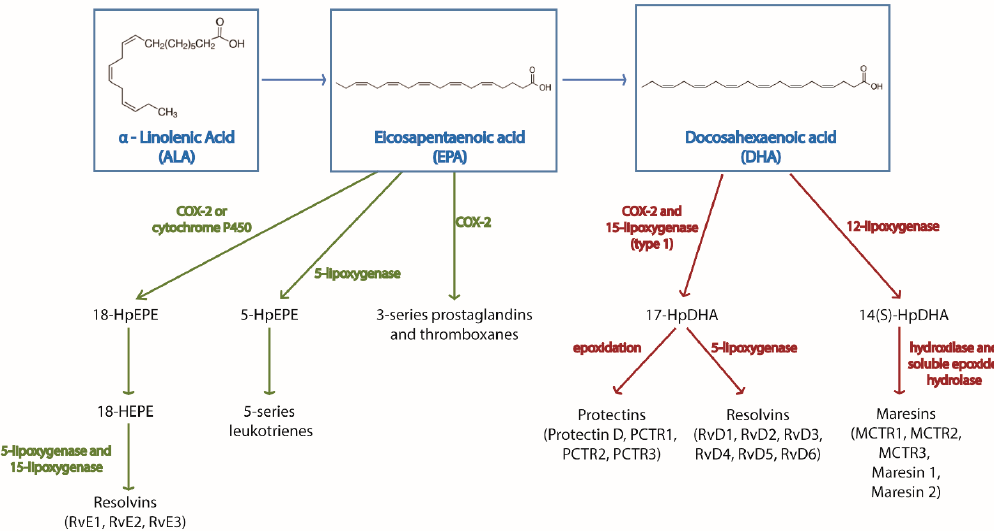
Figure 1. Main biochemical pathways for the synthesis of omega-3 derived metabolites. The figure shows the omega-3 fatty acids α -linolenic acid (ALA), eicosapentaenoic acid (EPA), and docosahexaenoic acid (DHA), their downstream metabolites and the enzymes regulating their synthesis.